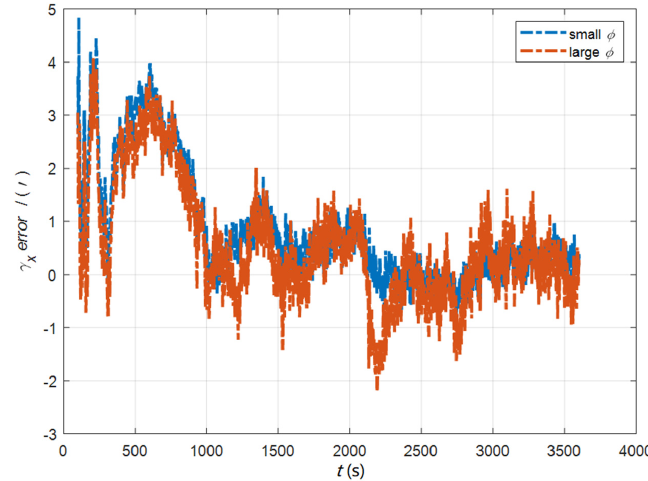
Figure 29. The error curves of γ x in the case of large and small initial misalignment angles.